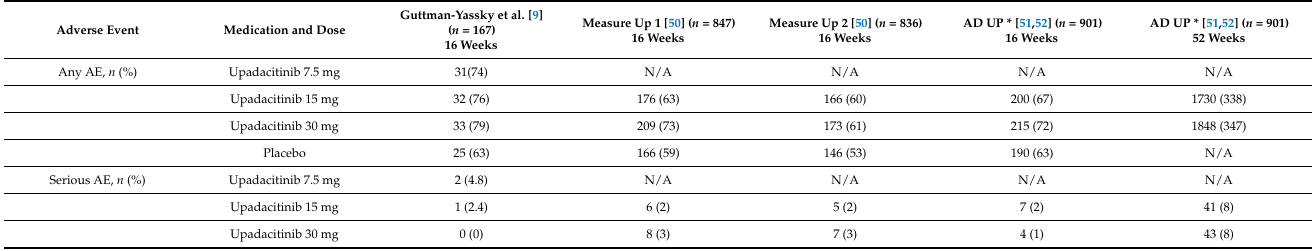
Table 2. Summary of safety outcomes for clinical trials completed with upadacitinib treatment in patients with moderate-to-severe atopic